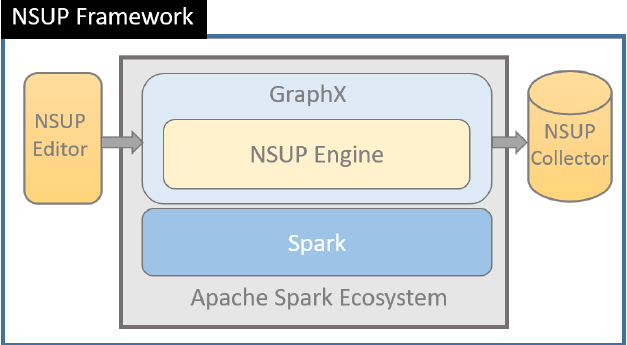
Figure 2. Spark GraphX architecture proposed for NSUP